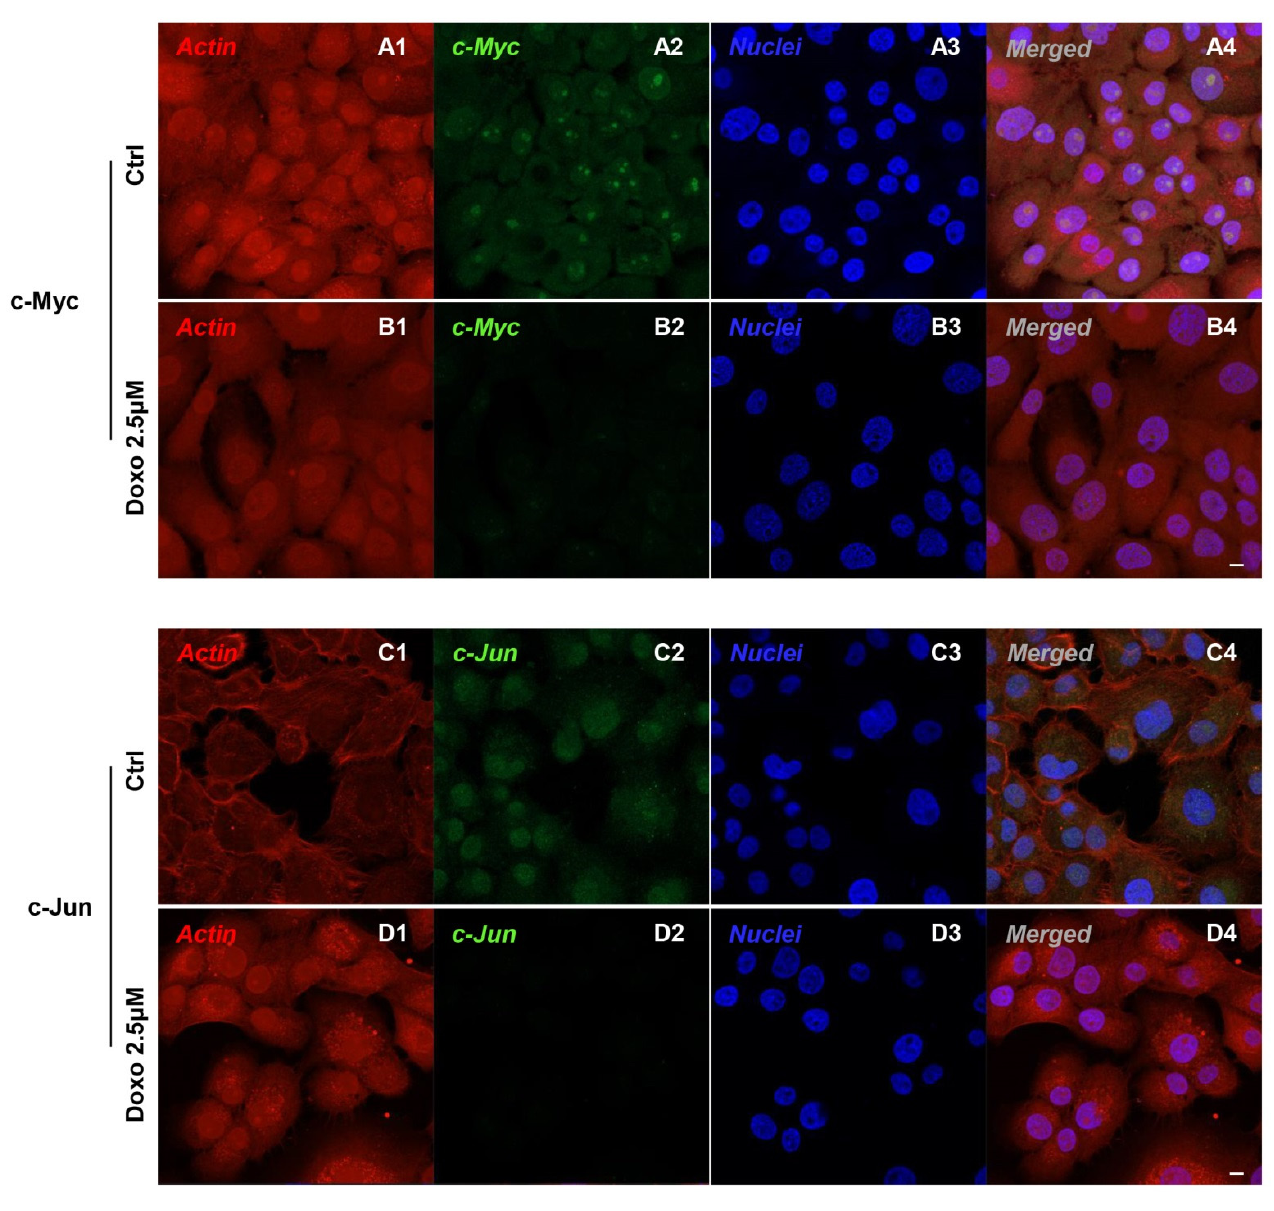
Figure 2. Confocal microscopic analysis on the expression of c-Myc and c-Jun in Cal-27 cell lines. Expression of c-Myc and c-Jun analyzed by confocal microscopy in untreated cells (CTRL) ( A1 – A4 , C1 – C4 ); expression of c-Myc and c-Jun expression in Cal-27 treated with Doxo 2.5 µM ( B1 – B4 , D1 – D4 ). Red fluorescence: cytoskeleton actin. Green fluorescence: c-Myc and c-Jun. Blue fluorescence: cell nuclei. Scale bar: 20 µm.